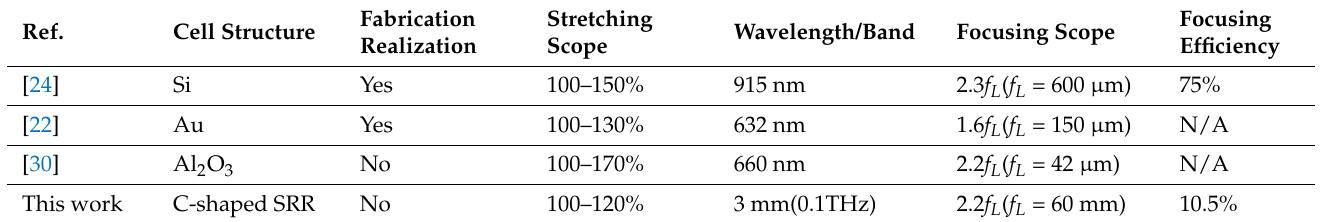
Table 2. Performance comparison between the designed meta-lens and the previously reported structures with PDMS